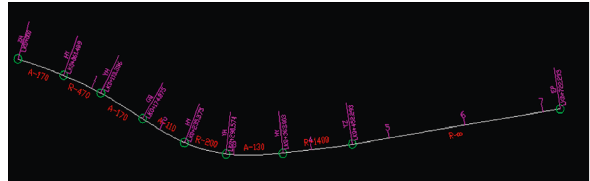
Figure 8: Logical layer of road